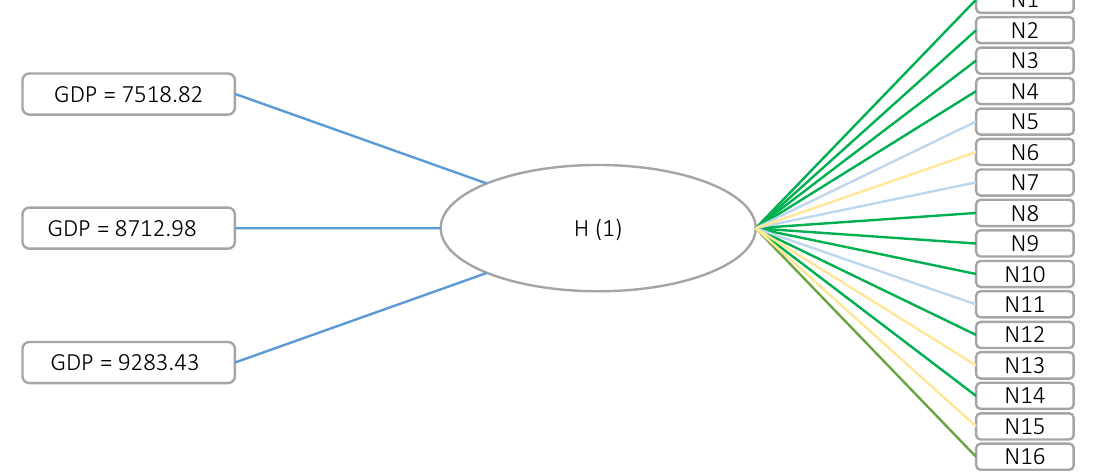
Figure 3. Graphs of the neural network of communication of indicators of reforms and programs of sustainable development effectiveness and the volume of GDP per capita of Ukraine for 2015–2019